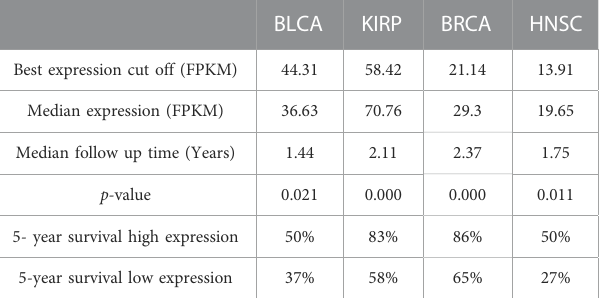
TABLE 1 Survival analysis of GSTK1 between BLCA, KIRP, BRCA, and HNSC using The Human Protein